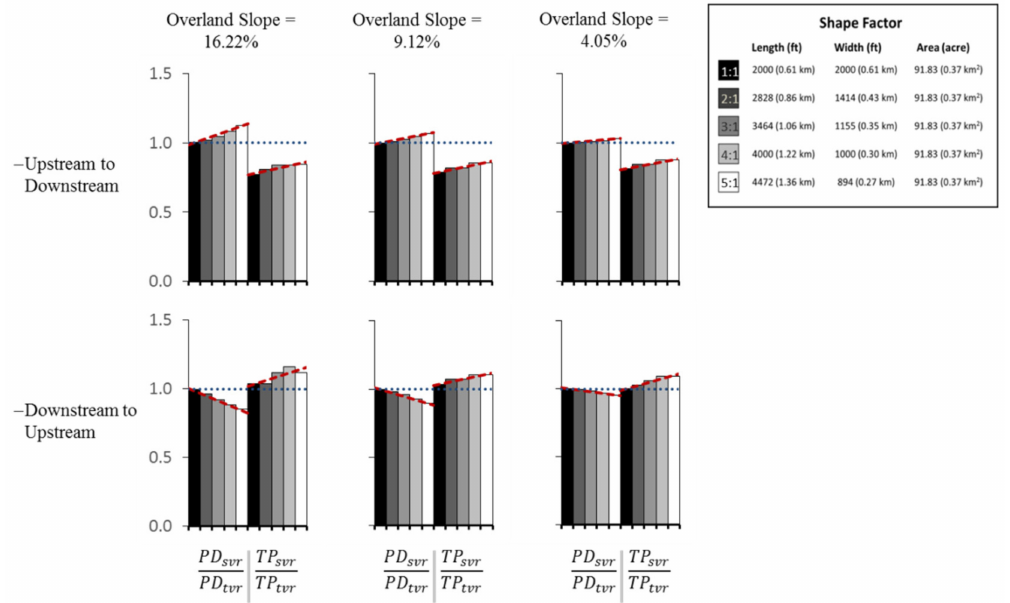
Figure 8. Synthetic rectangular drainage basins of constant area for peak discharge ratios (PDRs) and time to peak ratios (TPRs).